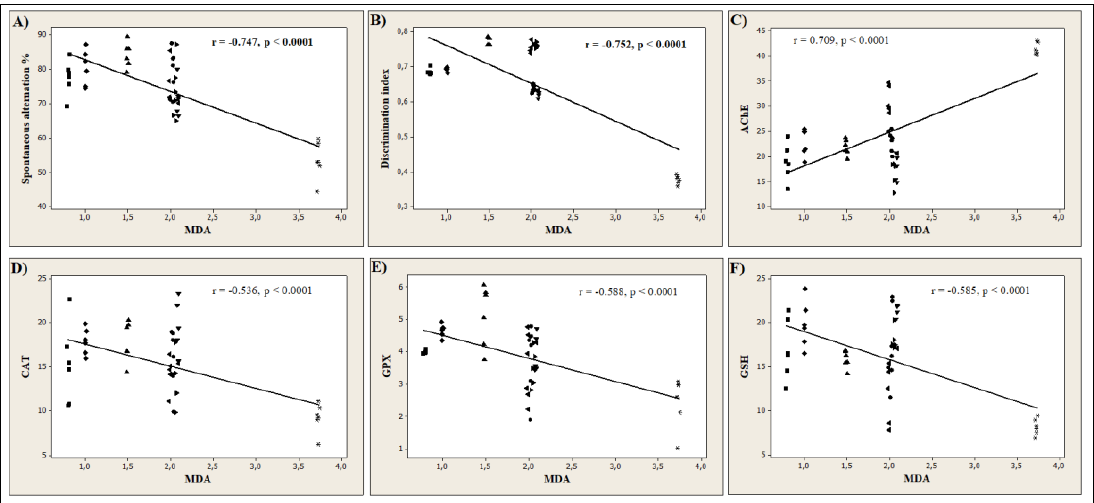
Figure 8. Pearson’s correlation between behavioral or biochemical parameters and the product of lipid peroxidation, MDA ( n = 6): ( A ) Spontaneous alternation% vs. MDA (r = −0.747, p < 0.0001), ( B ) Discrimination index vs. MDA (r = −0.752, p < 0.0001), ( C ) AChE vs. MDA (r = 0.709, p < 0.0001); ( D ) CAT vs. MDA (r = −0.536, p < 0.0001); ( E ) GPX vs. MDA (r = −0.588, p < 0.0001); ( F ) GSH vs. MDA (r =